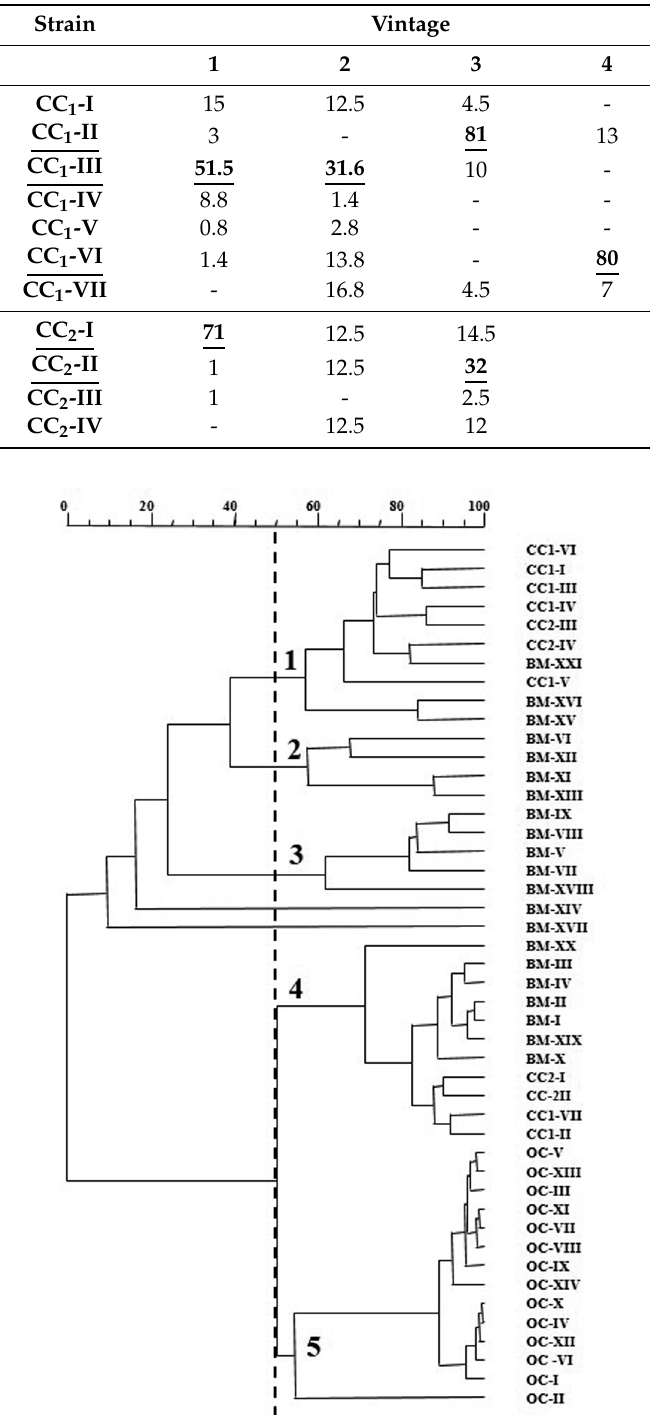
Table 5. The frequency (%) of S. cerevisiae strains recurring in two wineries (CC 1 and CC 2 located in the Chianti Classico wine area) in di ff erent vintages (underlined the predominant strains).